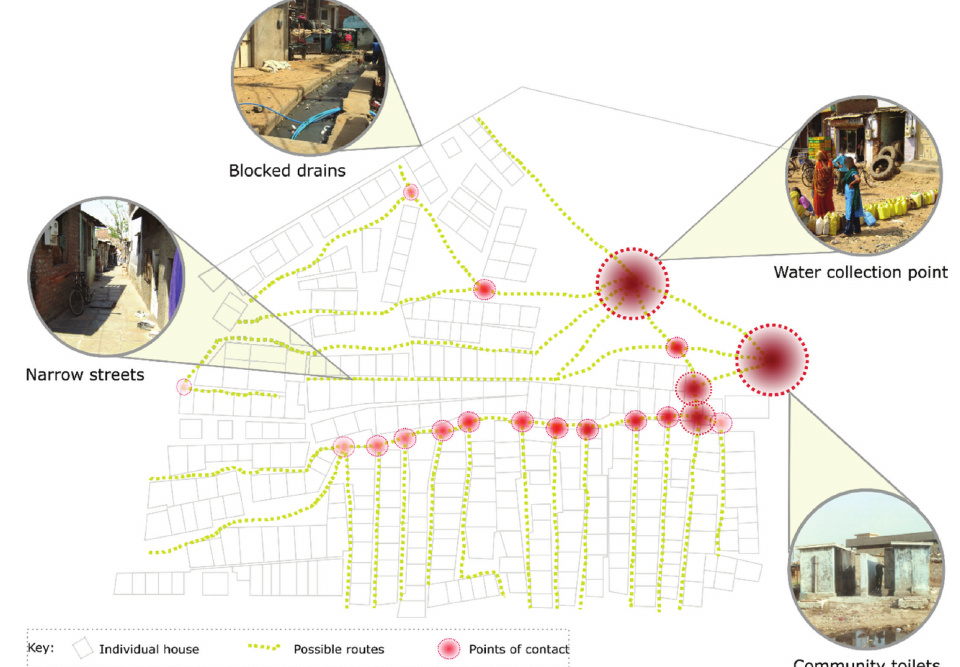
Illustrative representation of potential COVID-19 transmission pathways in slums in India and